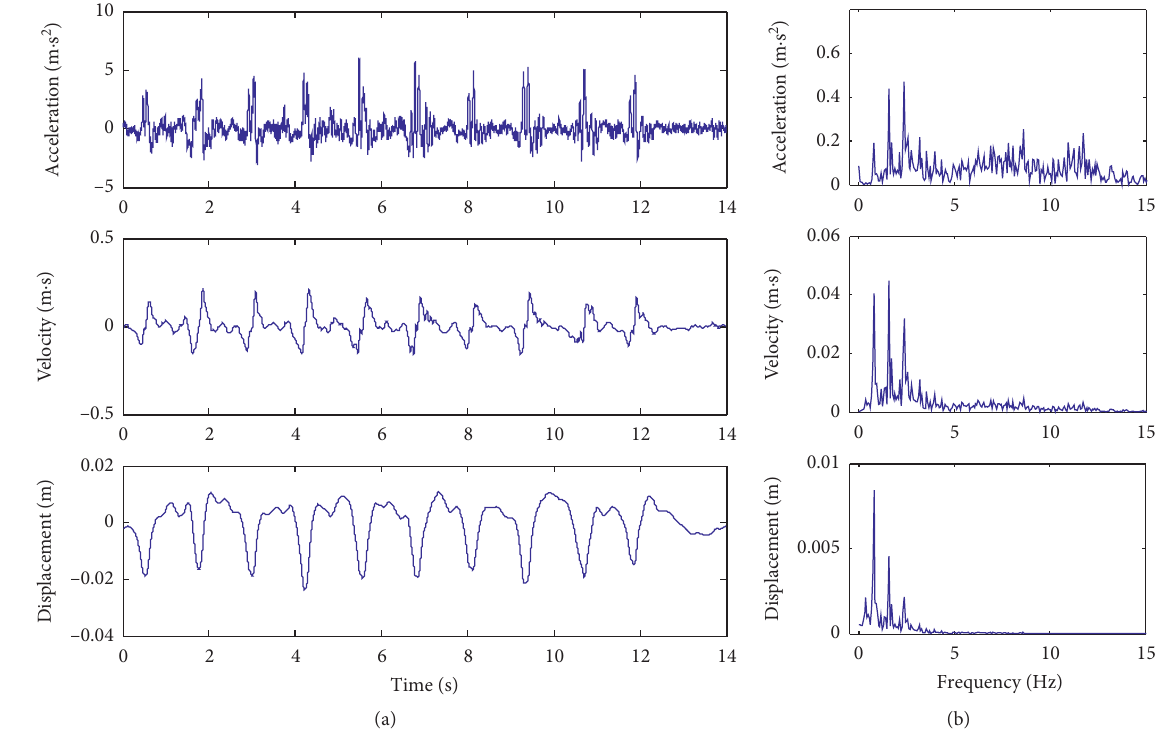
Figure 9: Primary and secondary frequency domain integration and time and frequency correspondence diagram of vibration acceleration signal. (a) Time domain diagram. (b) Frequency domain diagram.